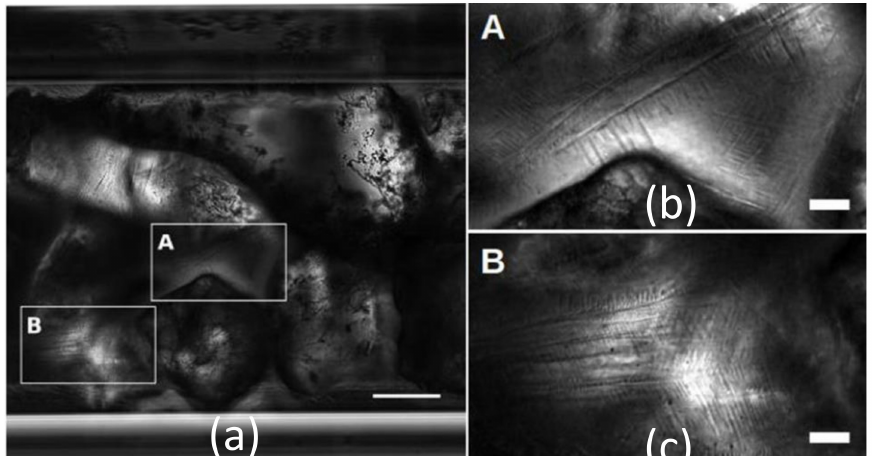
Figure 12. Feathered dendritic crystals of methane hydrate growing into capillary bridges between sand grains, at 7 MPa and − 16 ◦ C, in run 5: ( a ) Image with scale bar of 100 µ m; ( b ) image correspond- ing to zone A , scale bar of 20 µ m; ( c ) image corresponding to zone B , scale bar of 20 µ m.